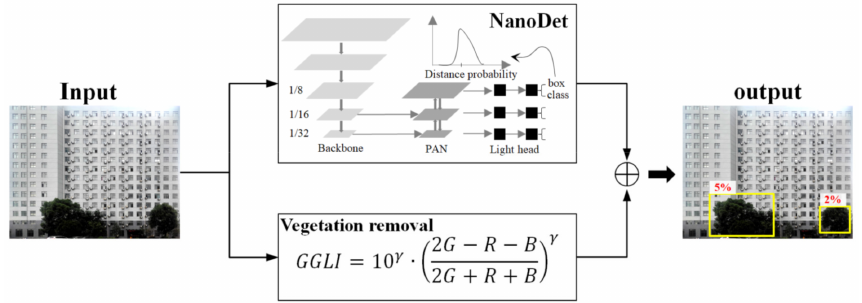
Figure 4. Object-occlusion detection combined with NanoDet and vegetation removal. γ denotes a gamma value, and R , G , and B are the three components of RGB